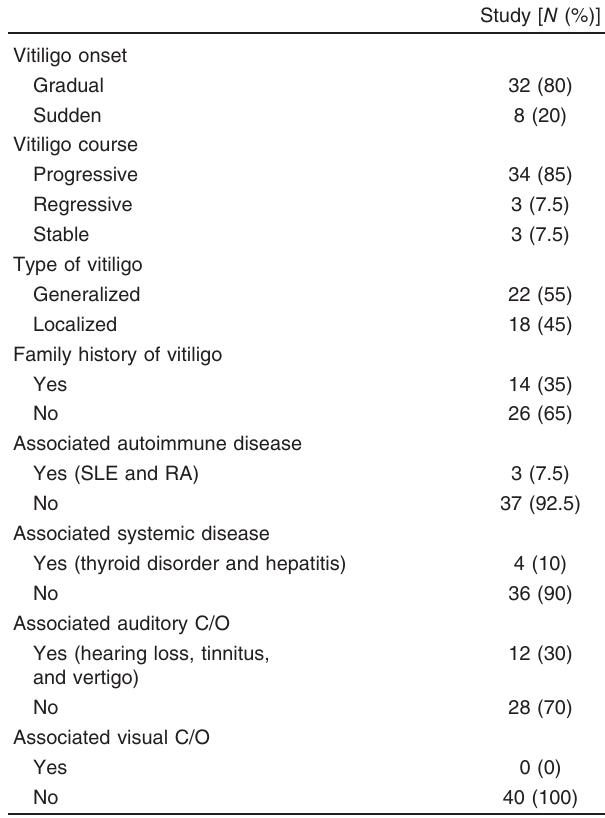
Table 1 Characteristic features of vitiligo in the study group and other associated systemic disorders